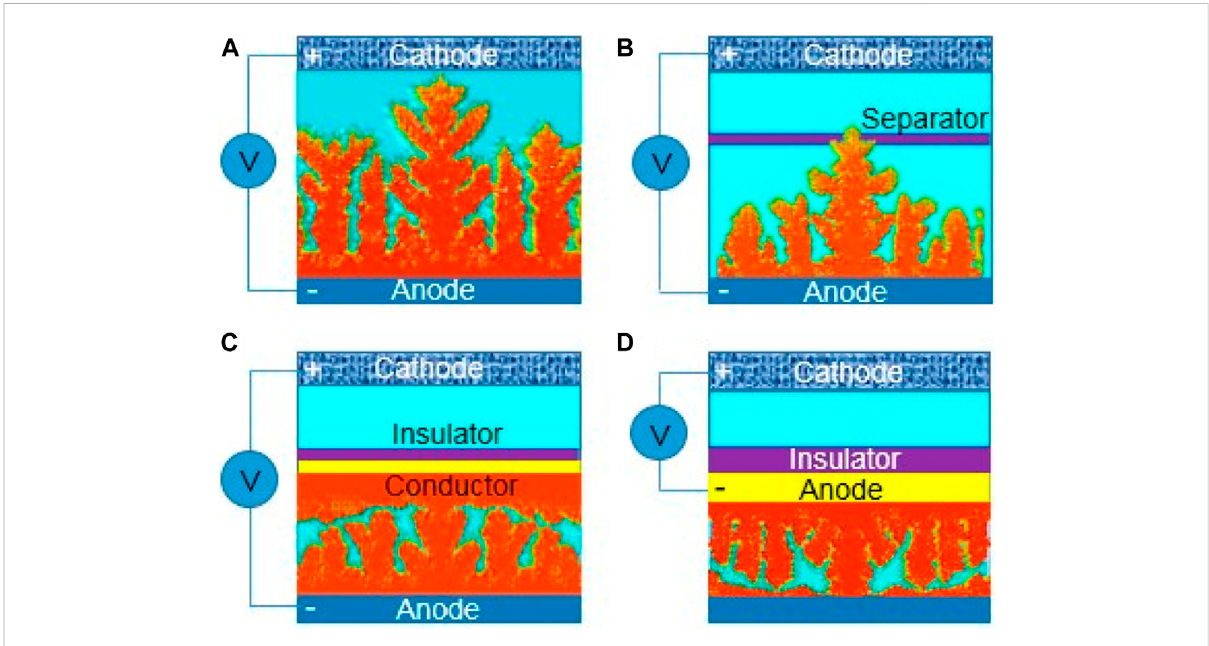
FIGURE 2 Dendrite growth of depositing zinc. (A) Dendrite growth causing short circuit of the batteries, (B) dendrite growth puncturing a separator, (C) partially conductive separator guiding dendrite growth, and (D) insulator encapsulating anode-reversing dendrite growth. Reproduced under the terms of the CC-BY Creative Commons Attribution 4.0 International license (Zhang et al., 2022). Copyright (2022), Energy